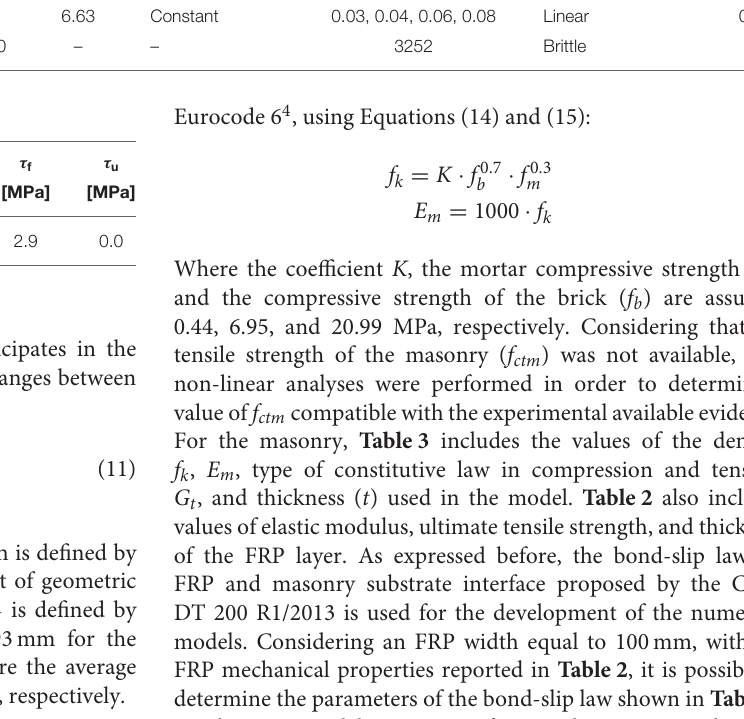
type was adopted for the eight node quadrilateral isoperimetric strain elements. The thickness of the arch was divided into 6 elements for a total of 1,152 elements. The boundary conditions were applied by restraining the nodes of the elements located at the left and right extremes of the arch. The load was applied by means of a displacement at the node located at the arch crow with 50 steps increment. For the analysis, non-linear material and non-linear geometry were considered. The iteration type for the iteration scheme was a Newton Raphson algorithm with 0.01 energy